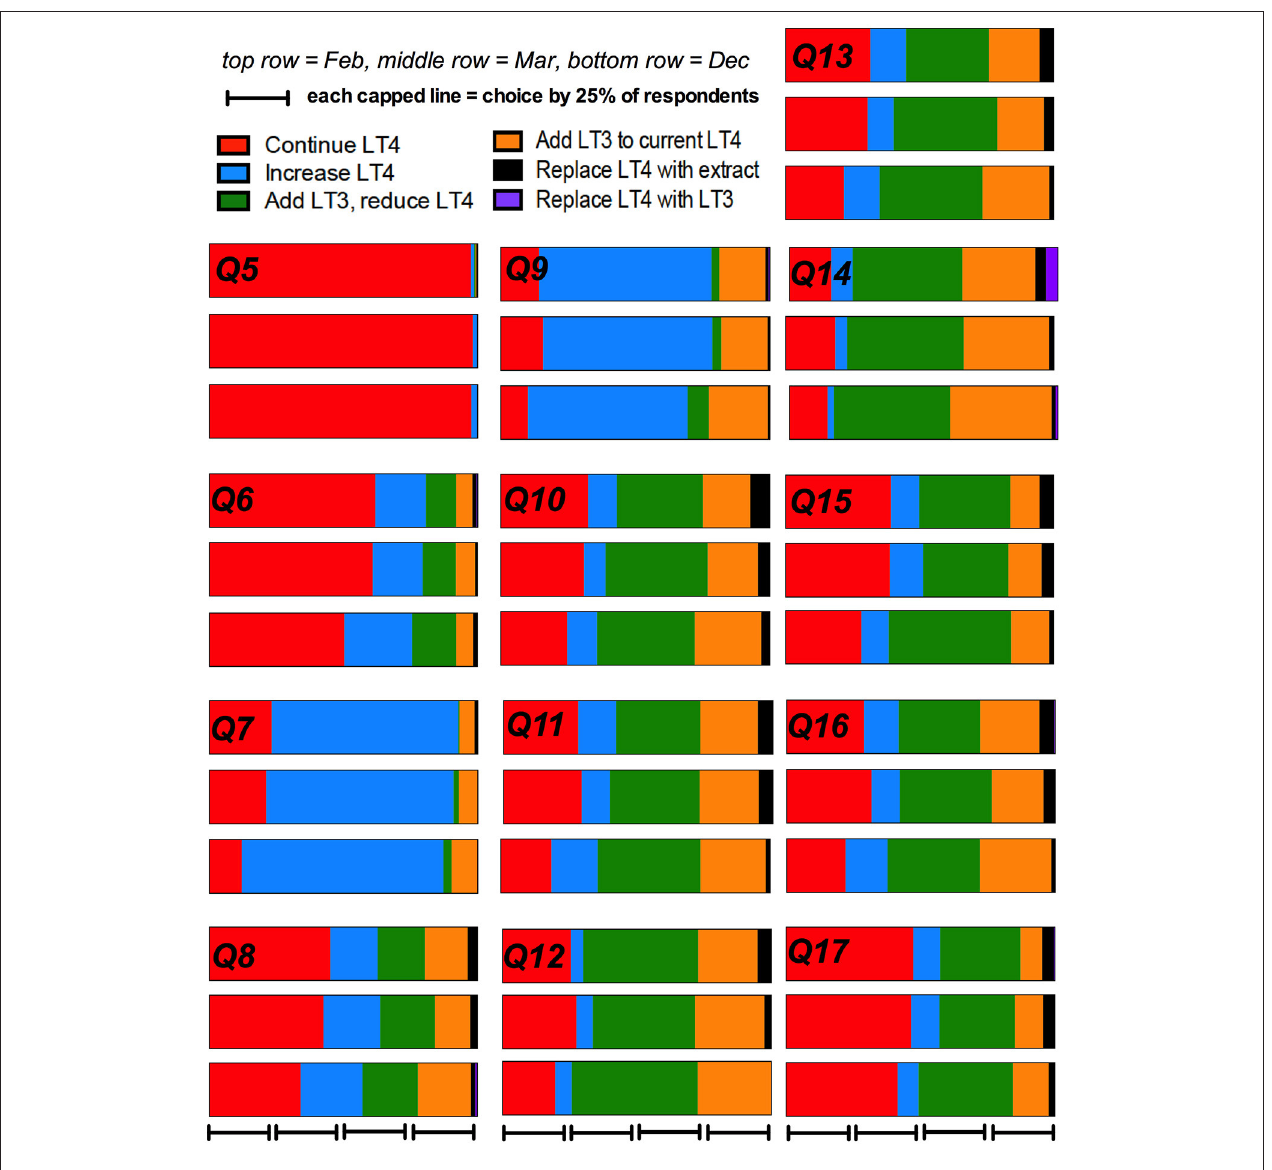
FIGURE 1 | Response to patient scenarios over